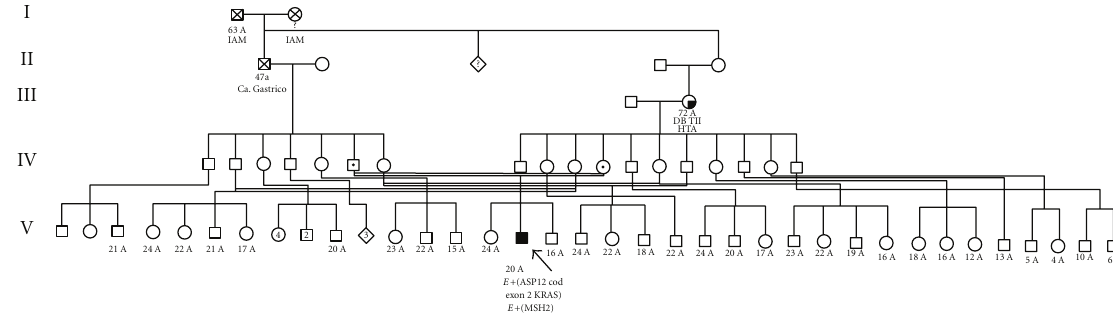
Figure 5: Pedigree of the family of the patient illustrates consanguinity in the second